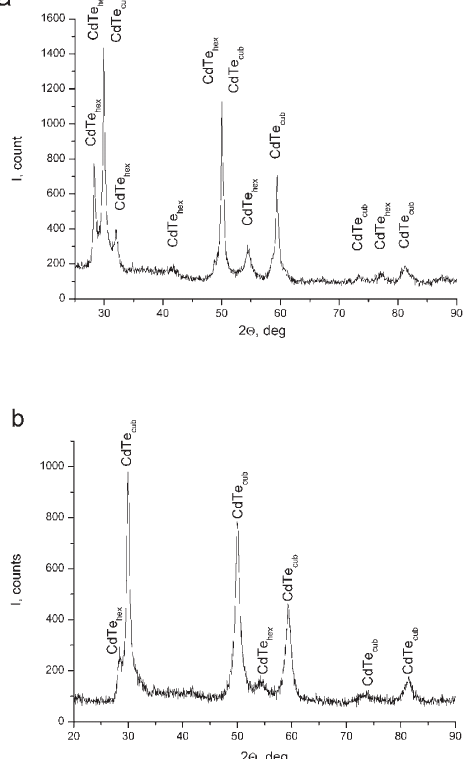
Figure 6. Diffractograms of CdTe: (a) nanopowder; (b) ceramics = 300ºC, produced by compaction of the powder at T = 25ºC, an p = 600 MPa.